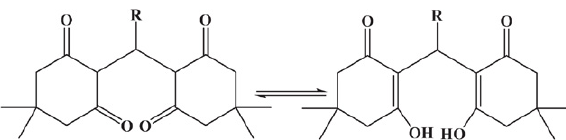
Figure 1. Tetraketones and their keto-enol tautomeric